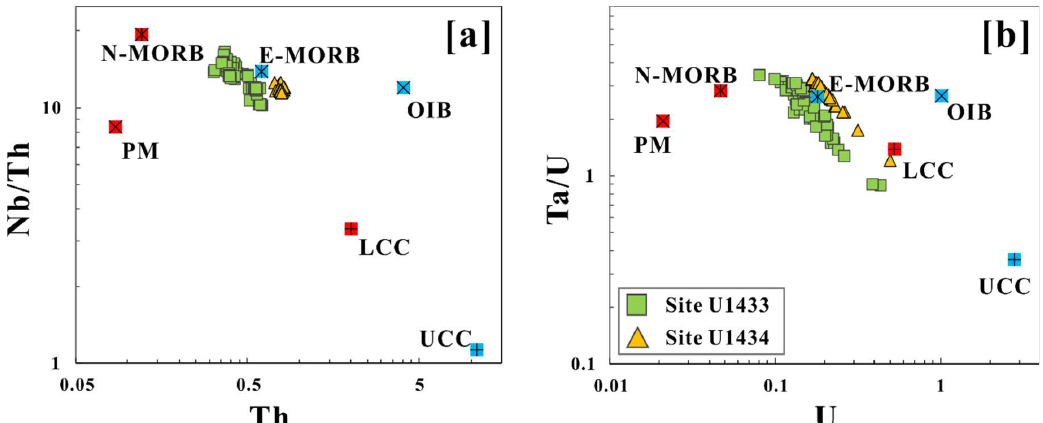
Figure 11. Diagrams of Nb/Th versus Th ( a ) and Ta/U versus U ( b ) for basaltic samples at Sites U1433 and U1434. Trace element abundances of the primitive mantle (PM) are from Hofmann [42], trace element abundances of E-MORB, normal mid-ocean ridge basalts (N-MORB), and Oceanic Island Basalt (OIB) are from Sun and McDonough [27], trace element abundances of lower continental crust (LCC) and upper continental crust (UCC) are from McLennan [47].